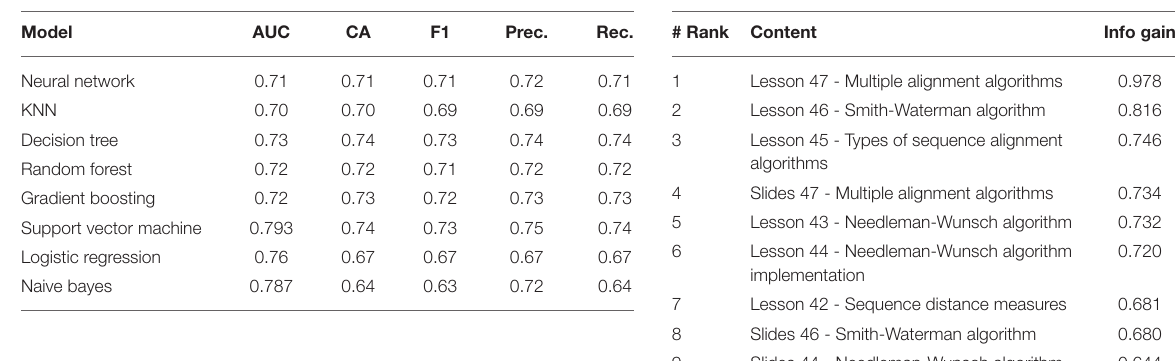
TABLE 3 | Top 10 course resources correlated with course